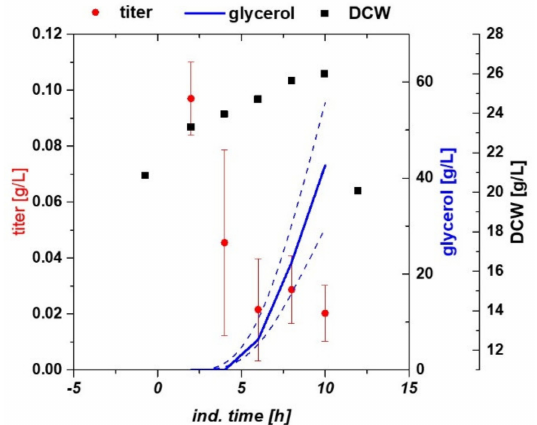
Figure 1. Centerpoint cultivations of E. coli expressing recombinant hyaluronidase. Recombinant protein expression is the highest at early induction times. As the protein is obviously hard to express, biomass growth decreases and glycerol accumulates in the broth over induction